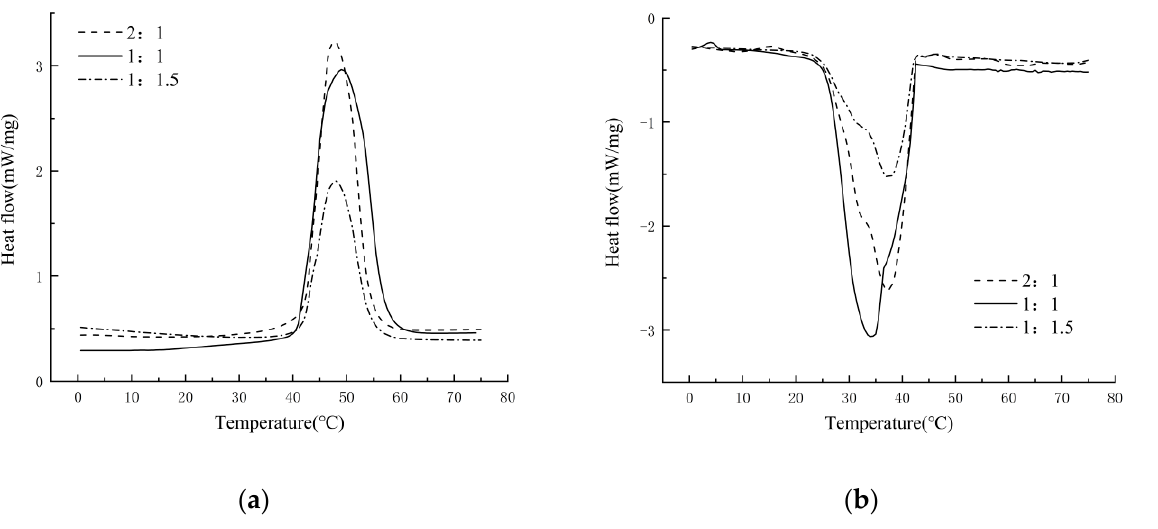
Figure 9. DSC curves of MPCMs with different core–shell ratios in the SDS ratio of 0.22%, an ultrasonic oscillation time of 10 min, and pH of 4.5. ( a ) Melting and ( b ) crystallization processes at a temperature rate of 10 K/min in a 60 L/min flow of N 2 . Table 9. Experimental results for changing the core–shell ratio.